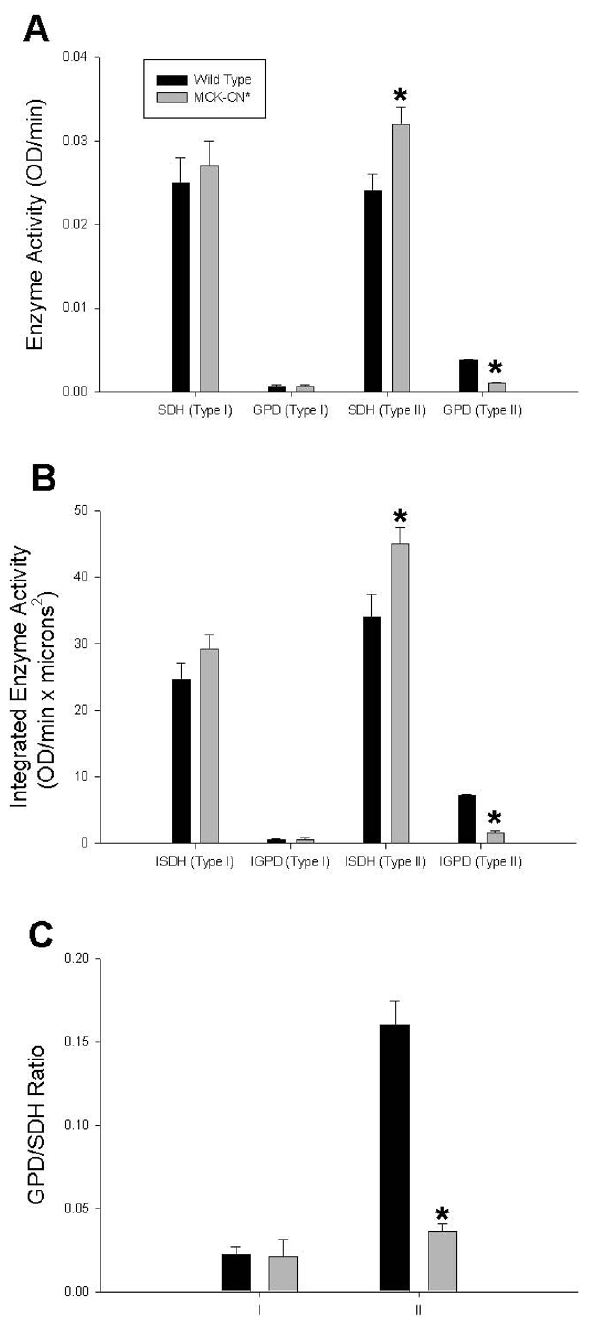
Figure 5 Oxidative and glycolytic enzymatic profiles of individual plantaris fibers of wild-type and MCK-CN* transgenic mice. The * denotes significantly different from wild-type at p ≤ 0.05. A) The specific activity of succinate dehydrogenase (SDH, oxidative marker) was increased in fast (type II) plantaris fibers, but unchanged in slow (type I) fibers. The specific activity of α -glycero- phosphate dehydrogenase (GPD, glycolytic marker) was significantly decreased in fast plantaris fibers, but not slow fibers. B) The integrated activity (see methods for explanation of integrated activity) of succinate dehydrogenase (SDH, oxidative marker) was increased in fast (type II) plantaris fibers, but unchanged in slow (type I) fibers. The integrated activity of α -glycer- ophosphate dehydrogenase (GPD, glycolytic marker) was significantly decreased in fast plantaris fibers, but not slow fibers. C) The GPD/SDH ratio (glycolytic/oxidative ratio) was significantly decreased in fast fibers, but unchanged in slow fibers of the plantaris of MCK-CN* mice relative to